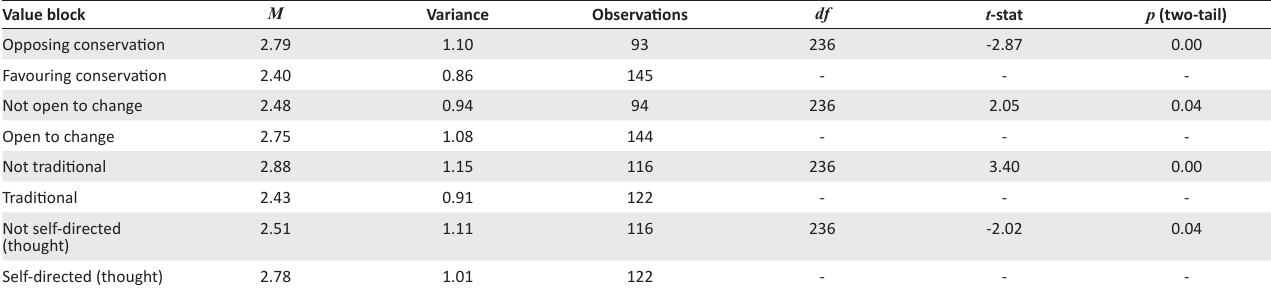
TABLE 4: The t -test results for decision-making quality and value blocks. Value block